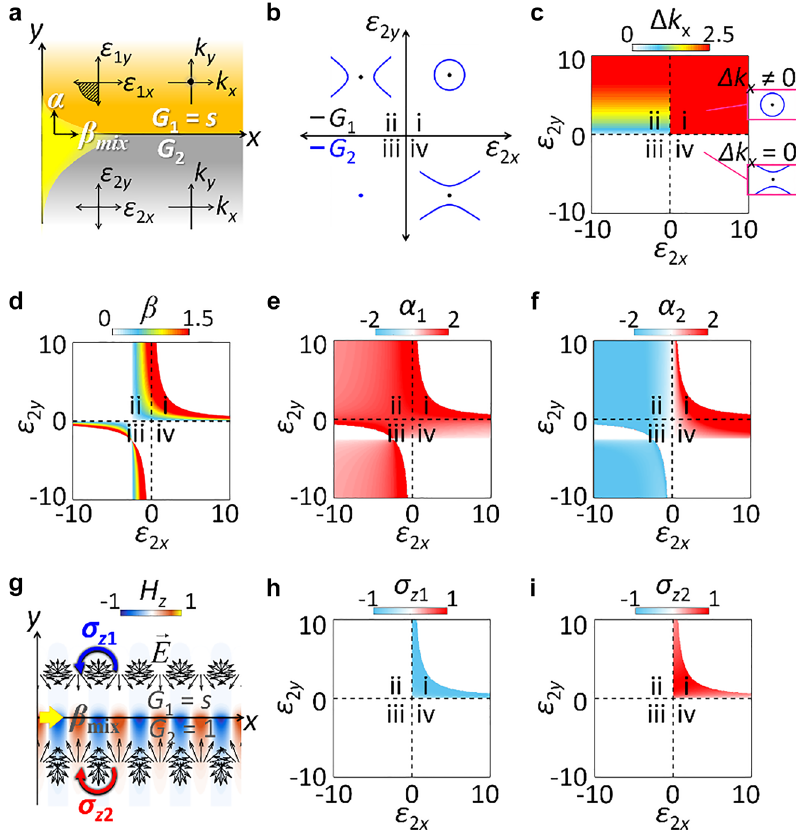
Figure 3: Lifshitz interface at different IFC dimensionalities. (a) An interface between a metallic layer ( G 1 = s ) and a varying layer ( G 2 ). (b) Four quadrants of IFCs in the material parameter space of the varying bottom layer (i: G 2 = 1, ii: G 2 = − 1, iii: G 2 = s , iv: G 2 = − 1), with the metal top layer ( G 1 = s ). (c – f ) Phase diagrams for (c) Δ k x , (d) β , (e) α 1 , and(f) α 2 .(g) H z pro fi leforamixedT-spinmodeattheLifshitzinterfacehavingdifferentIFCdimensionalities( G 1 = s with ε 1 x = − 2, ε 1 y = − 2,and G 2 =1with ε 2 x =0.5 ε 2 y =1.5).Blackandblue/redarrowsdenote E - fi eldandtheT-spinhandedness.(handi)PhasediagramsforT-spindensity